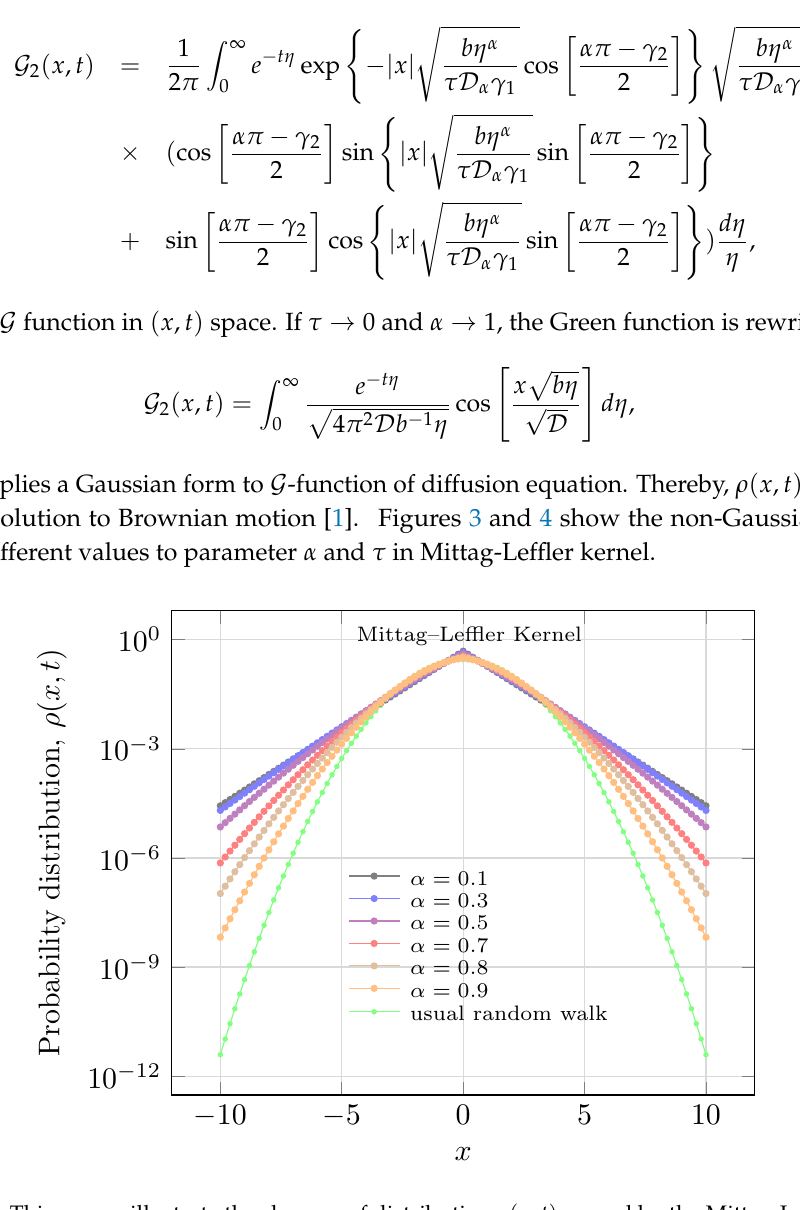
( t ) = δ ( t ) (or α = 1 and τ 0 K → b − 1 = 1, t = 1, τ = 10 − 2 and different values to index α D